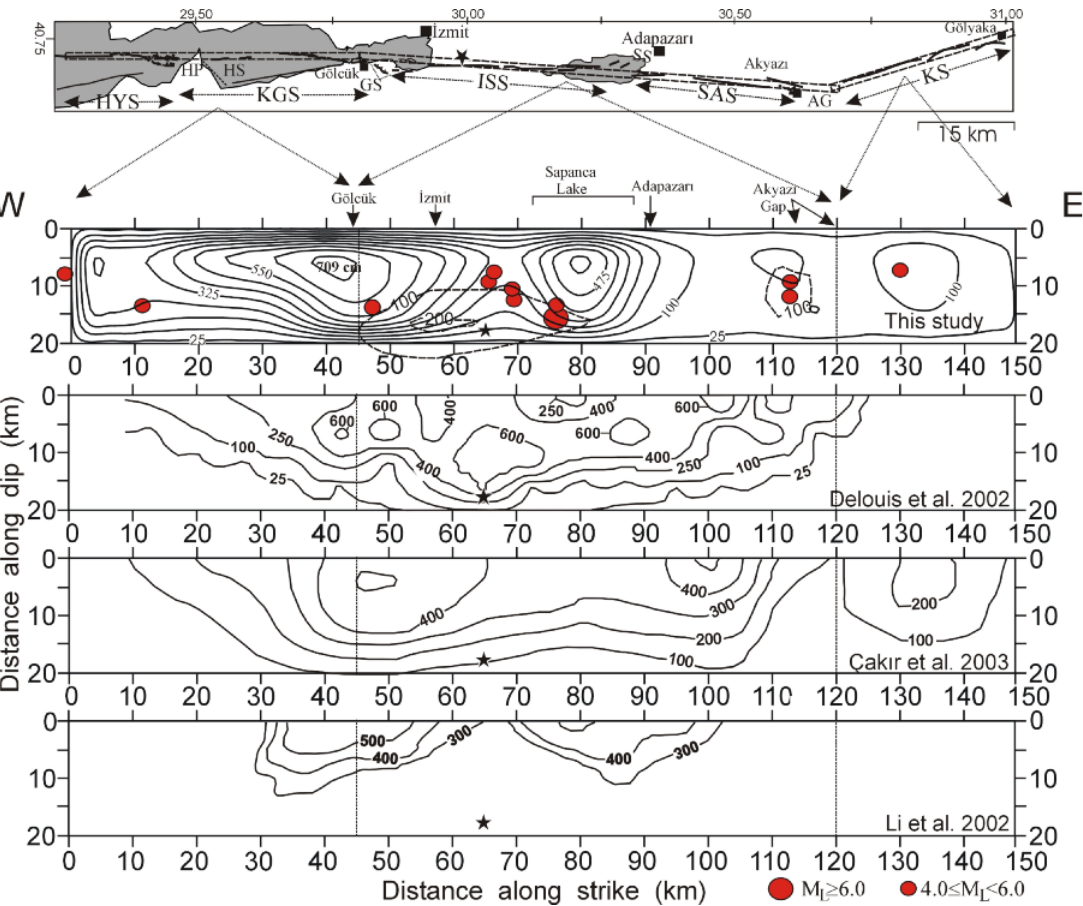
! Figure 11. Comparison of the slip models arising in the present study for the 1999 İ zmit earthquake with the slip models from previous studies. Thirty- day-long postseismic afterslip derived geodetically by Çakır et al. [2003] is indicated with broken-line contours in the slip model of the present study. The map of the surface rupture extent for correlating the slip distribution in the depth with the surface rupture trace is also shown. See caption of Figure 3 for